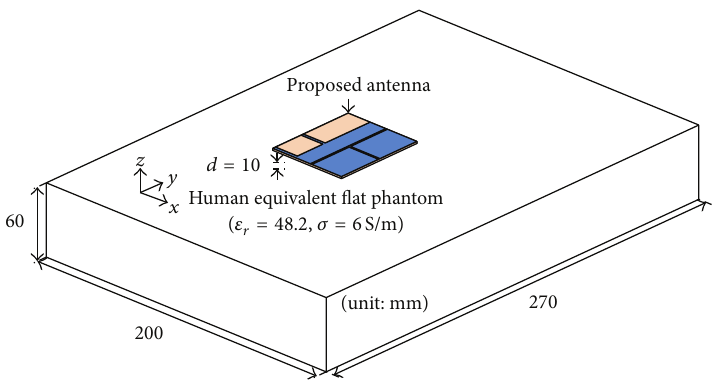
Figure 2: Simulation set-up of the proposed antenna on the